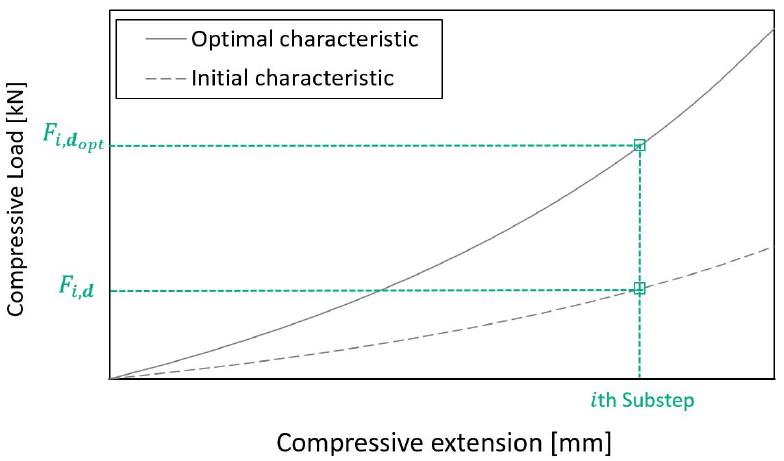
Figure 2. The finite element model of the rubber bumper and the obtained deformation state at 12 mm prescribed displacement.